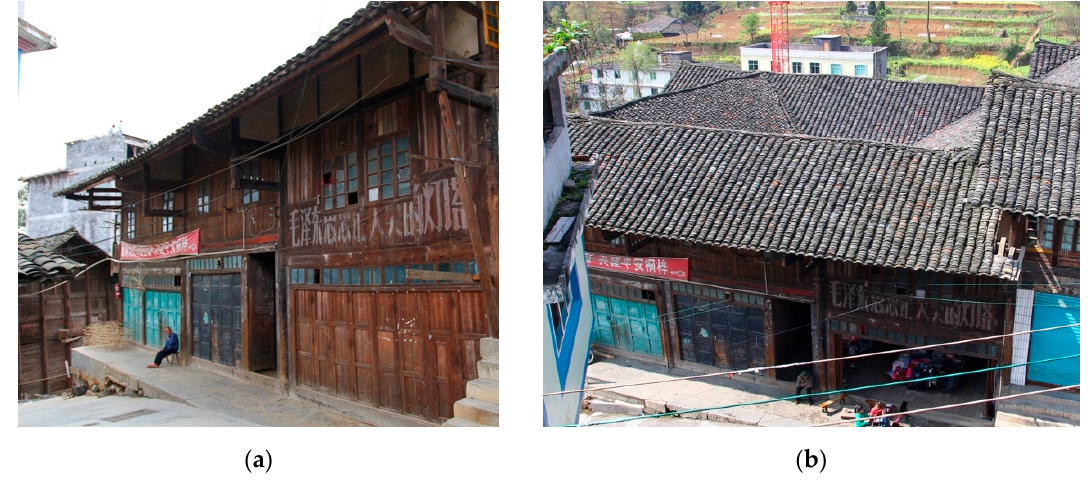
Figure 1. The selected vernacular courtyard house: ( a ) southwest façade, and ( b ) bird’s-eye view .